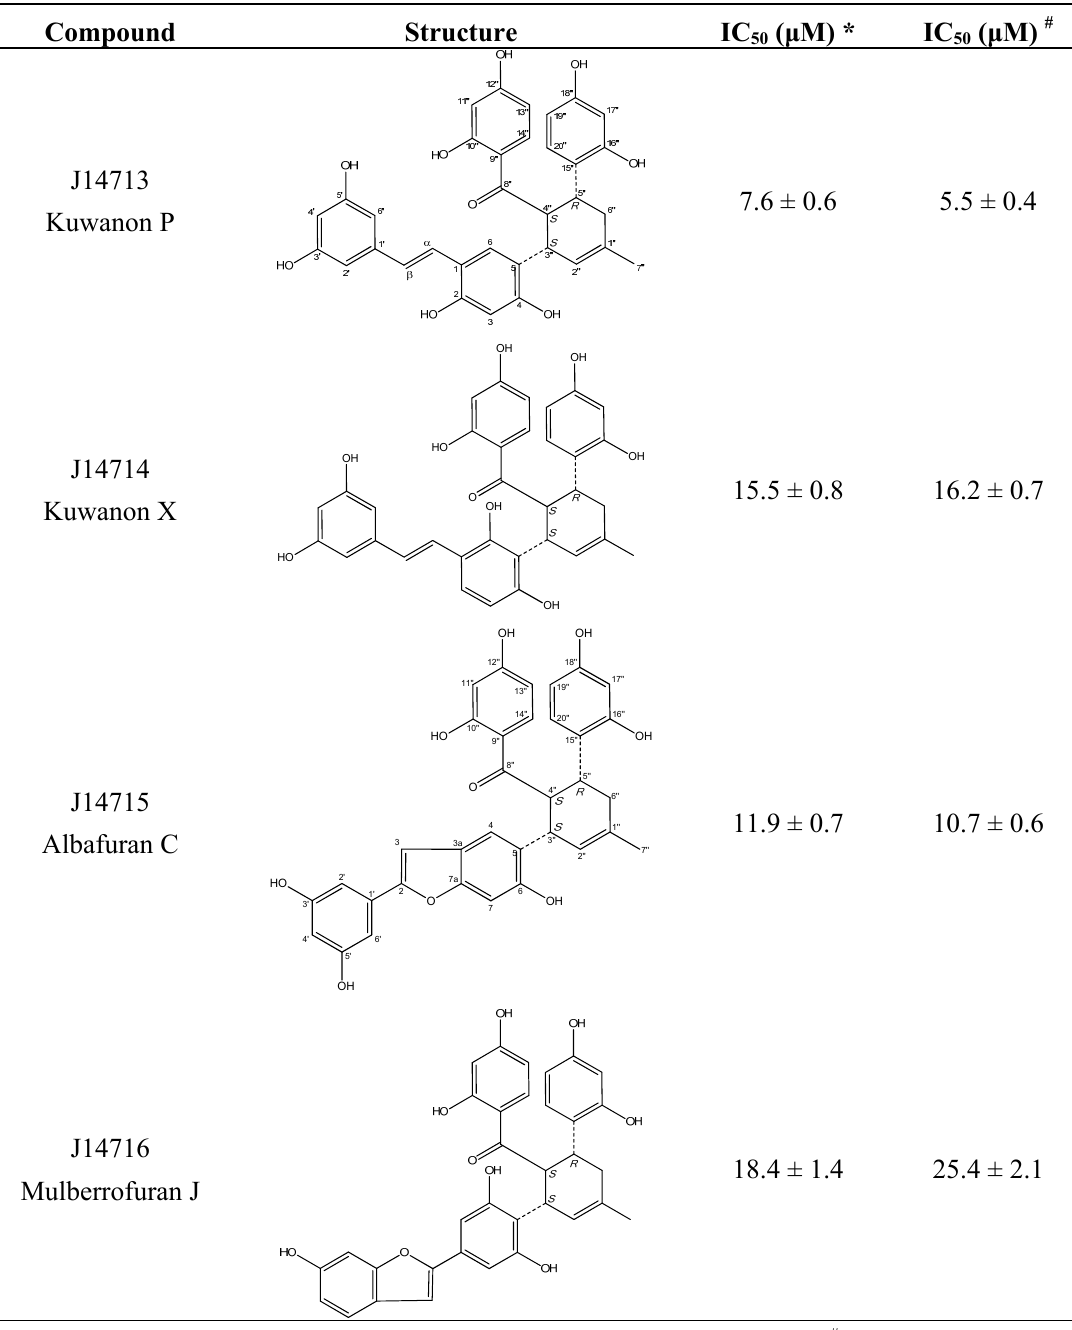
of hit compounds. (IC 50